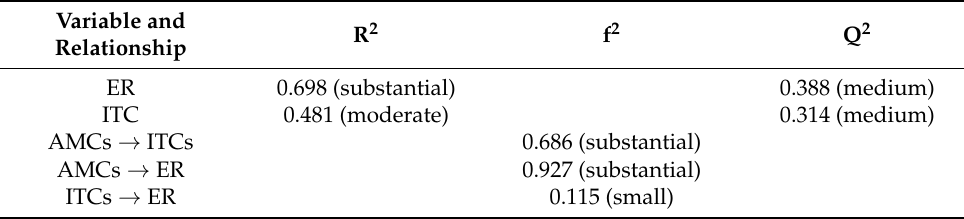
Table 2. Structural model assessment.